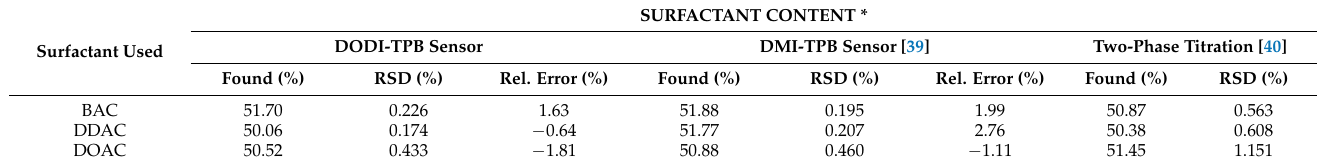
Table 3. Results of potentiometric determination of some technical cationic surfactants using SDS ( c = 4 mM) as a titrant and DODI-TPB as an indicator for ionic surfactants compared to results obtained with the DMI-TPB sensor for ionic surfactants and the standard two-phase titration method.